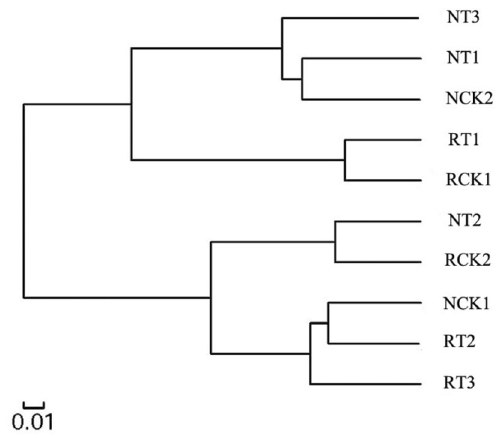
Figure 7. Clustering tree of soil bacteria in the different treatments. RCK1: R-soil in CK1; RCK2: R-soil in CK2; RT1: R-soil in T1; RT2: R-soil in T2; RT3: R-soil in T3; NCK1: N-soil in CK1; NCK2: N-soil in CK2; NT1: N-soil in T1; NT2: N-soil in T2; NT3: N-soil in